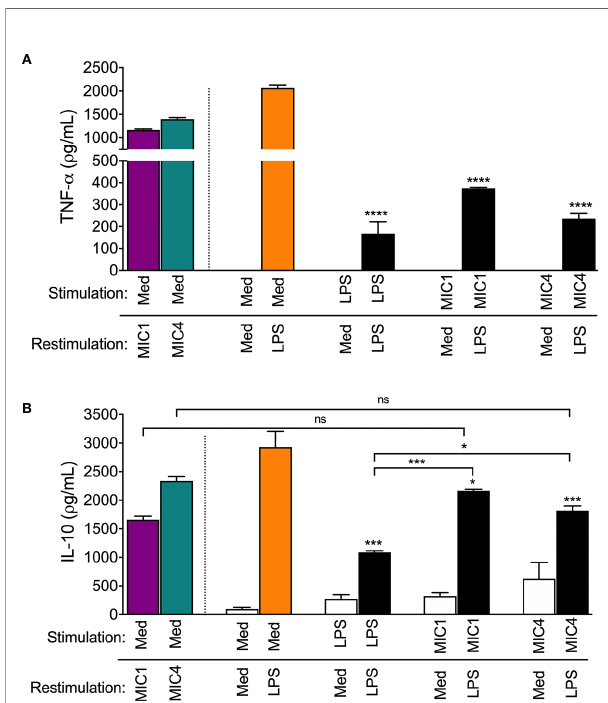
FIGURE 5 | MIC1 and MIC4 induced LPS tolerance in BMDMs. BMDMs were stimulated with Medium only (Med), LPS, MIC1, or MIC4. After 18 h, cells were washed and restimulated for an additional 24 h with medium or LPS. Cell supernatants were assessed for TNF- a (A) and IL-10 (B) concentrations. Mock-stimulated cells (Med) restimulated with MIC1 or MIC4 (purple and green bars) were used as controls. Results are expressed as averages + SD of three independent experiments, each performed in triplicate. Statistical analysis was performed by two-way ANOVA followed by Tukey ’ s test. * = p < 0.05, *** = p < 0.001 and **** = p < 0.0001, in comparison with cells stimulated with Med and restimulated with LPS (orange bars), or as